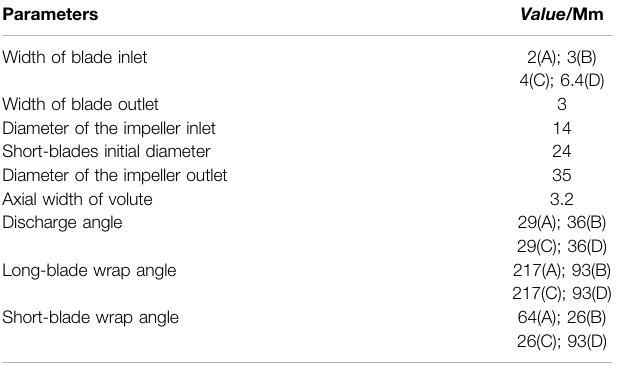
TABLE 1 | Geometrical parameters of the pump. Parameters